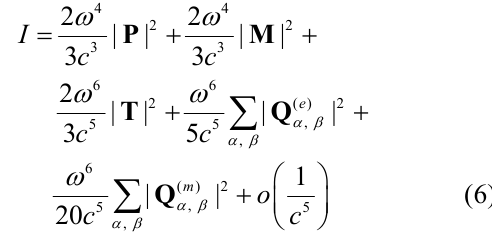
Fig. 3 Electromagnetic field distribution of two modes: (a) and (d) orientation of displacement current (red cones) and magnetic field vector (blue cones) is within the structural units of two modes; (b) and (e) electromagnetic field distribution of two modes in the x-y plane ( z is half height of cylinder); (c) and (f) electromagnetic field distribution of two modes in the x - z plane and x-z plane, respectively. The black arrow represents the magnetic field vector, and the white arrow represents the displacement